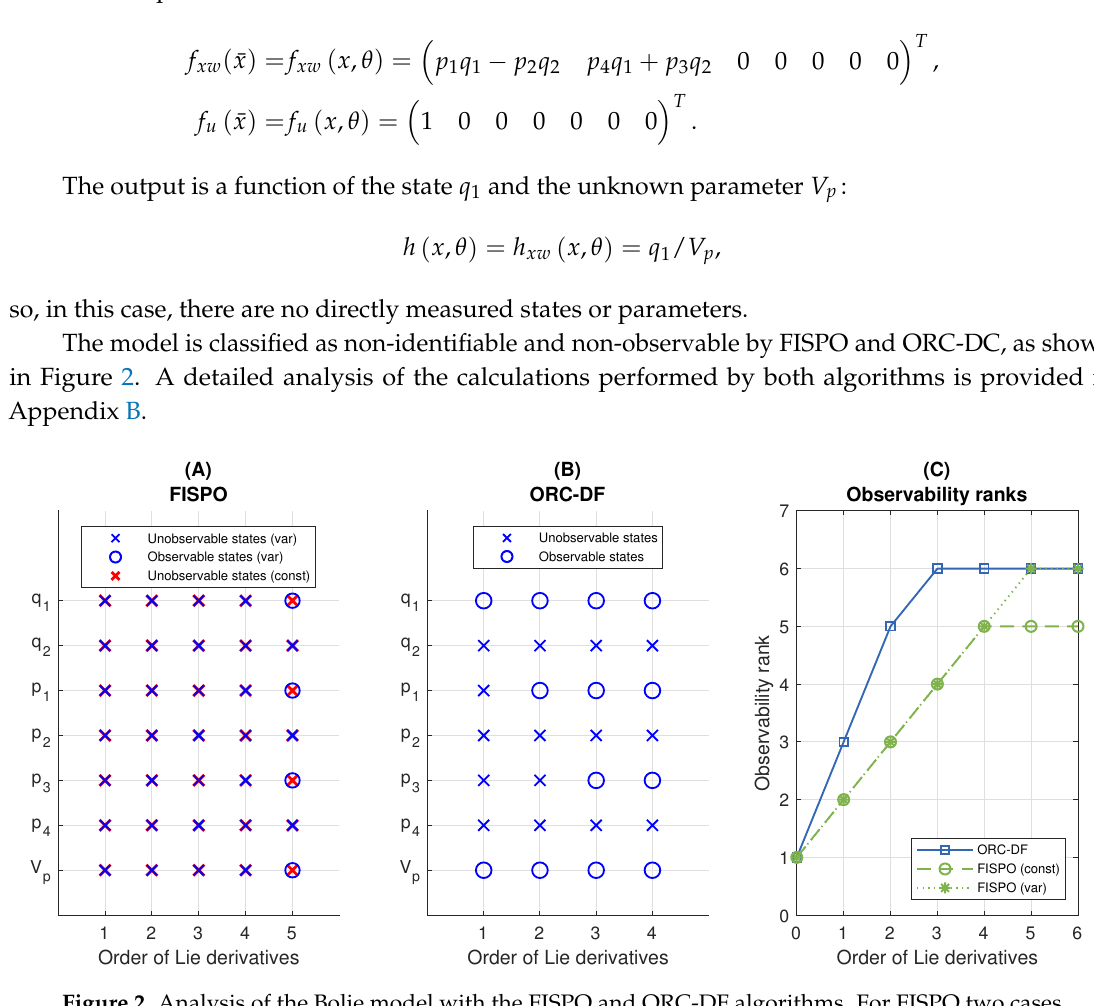
Figure 2. Analysis of the Bolie model with the FISPO and ORC-DF algorithms. For FISPO two cases are considered: ˙ u = 0, which is labelled as “(const)”, and ˙ u (cid:54) = 0, which is labelled as “(var)”. In the first case, higher order derivatives are assumed to be zero too. ( A , B ) Results of the FISPO and ORC-DF algorithms, respectively: the panel shows the states classified as observable or unobservable as a function of the number of Lie derivatives calculated by each algorithm. ( C ) Observability rank obtained by each algorithm as a function of the number of Lie derivatives. The full rank is equal to the number of states, i.e.,